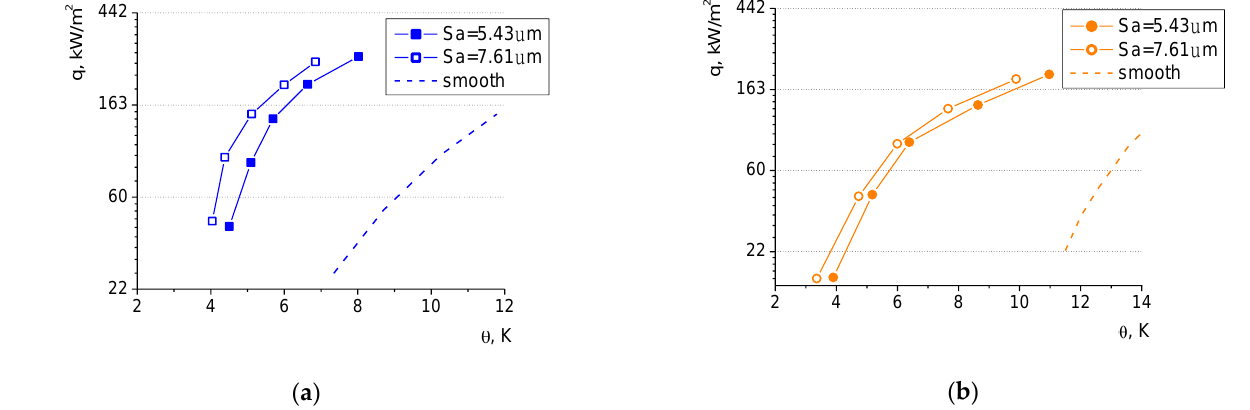
Figure 20. Boiling curves for the same microfin height of 0.25 mm for two surface roughness values for ( a ) water and ( b ) ethyl alcohol.